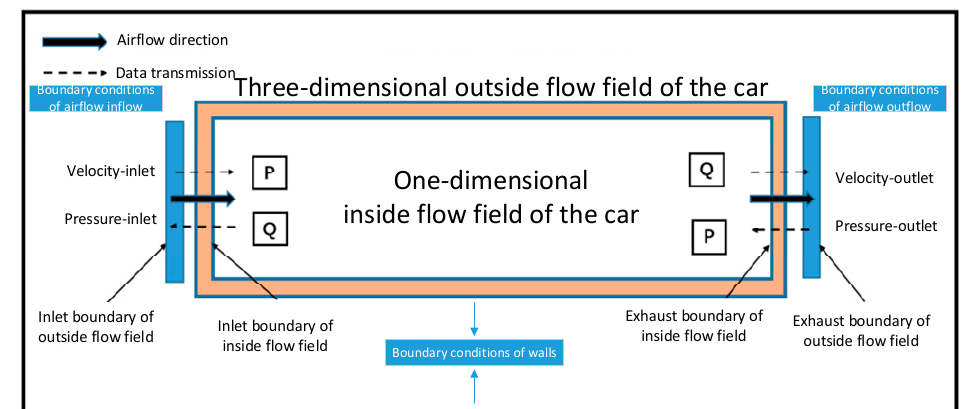
Figure 1. Coupling characteristic of the IE ‐ FF of the car (rotated 90 ° ).